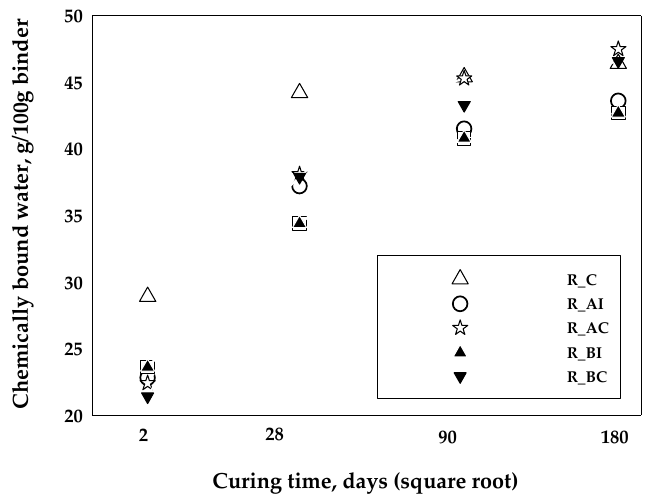
Figure 5. CBW determined up to 180 days of curing (w/b = 0.5 and normalized to 100 g of dry binder) for R_C, R_AI, R_AC, R_BI and R_BC.